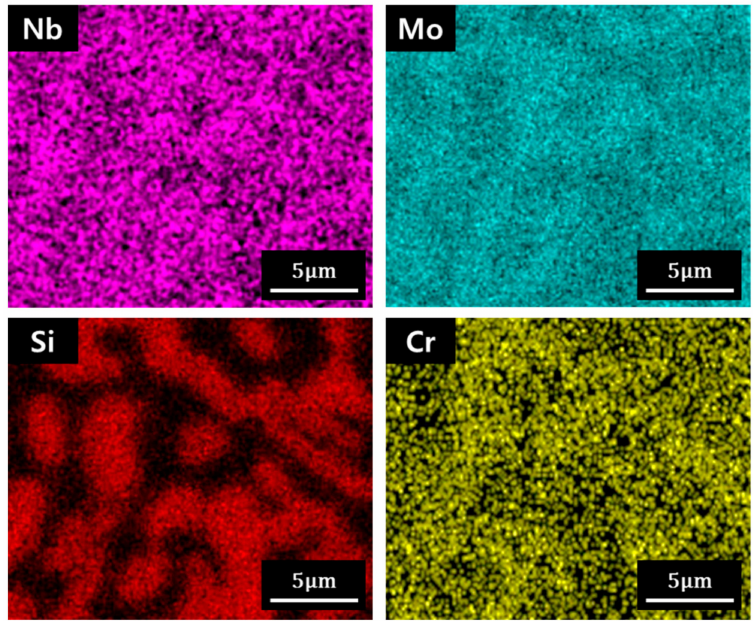
Figure 5. EDS mapping result of the compact sintered at 1600 ◦ C. Mapping was performed in the same region as the microstructure image on the right side in Figure